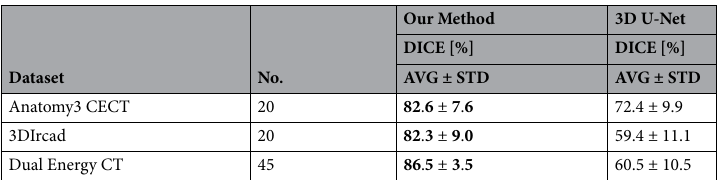
Table 2. Multi-modal liver segmentation accuracy using pre-trained CT model for Anatomy3 CECT, 3DIrcad and DECT datasets acquired with different scan protocols, and cross-validation on CHAOS CT-MR dataset. The accuracy of CHAOS CT-MR dataset is further broken down into individual modalities.